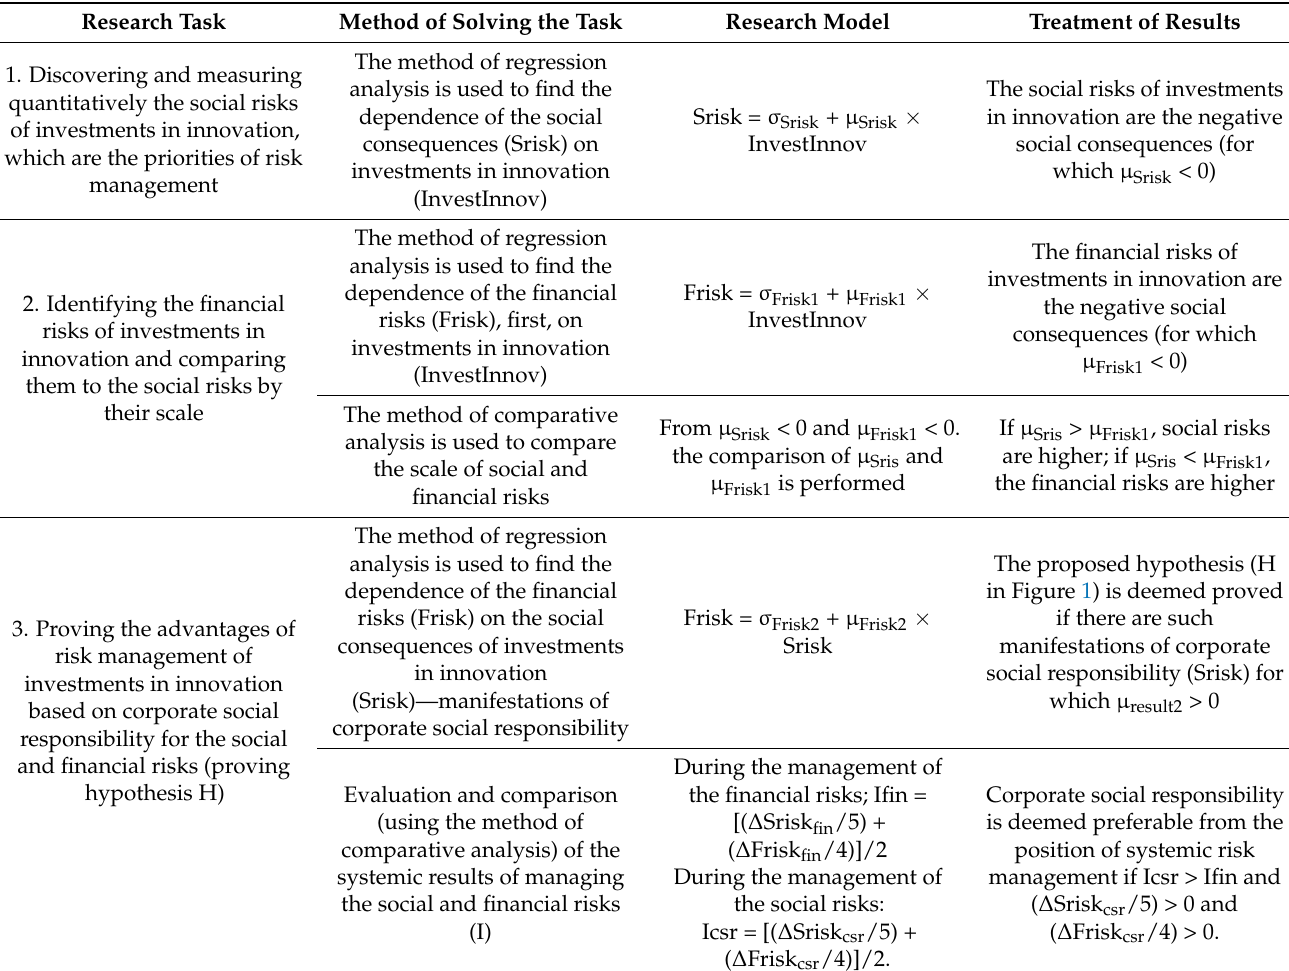
Figure 1. Research question (RQ) and hypothesis of the study. Source: authors. The formulated goal and tasks predetermined the strategy (logic and order) of this research (Table 4). Table 4. Strategy of the research.